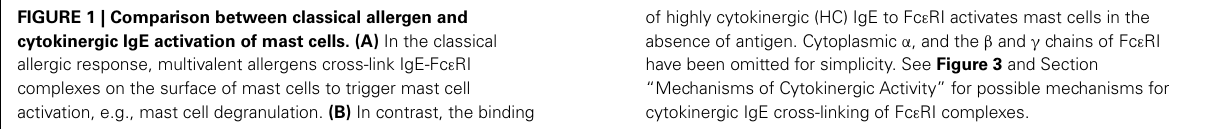
of highly cytokinergic (HC) IgE to Fc ε RI activates mast cells in the absence of antigen. Cytoplasmic α , and the β and γ chains of Fc ε RI have been omitted for simplicity. See Figure 3 and Section “Mechanisms of Cytokinergic Activity” for possible mechanisms for cytokinergic IgE cross-linking of Fc ε RI